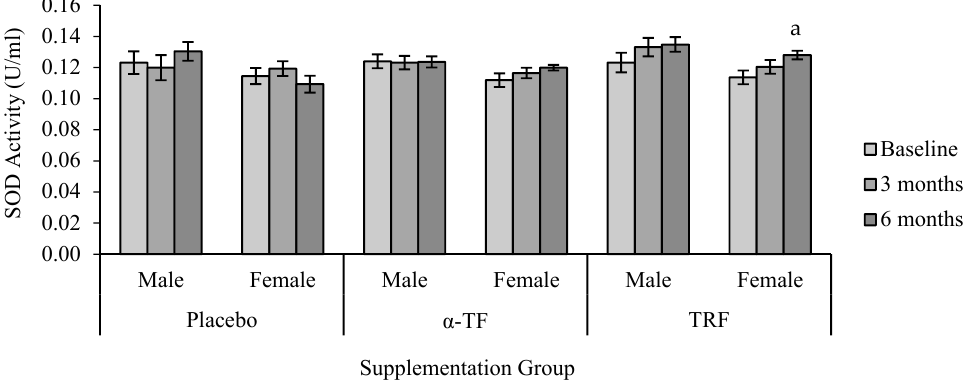
Figure 2. Effect of α -TF and TRF supplementation between males and females on SOD activity for 6 months. a = statistically significant compared to 0-month TRF group (female), p < 0.05.